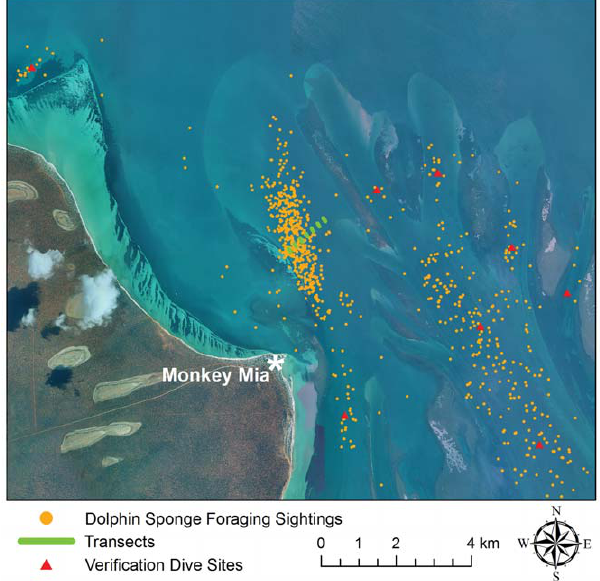
Figure 2. Sponging Map. Boat launch site (Monkey Mia), dolphin sponge foraging sightings, transects, and verification dive sites in Shark Bay, Western Australia.